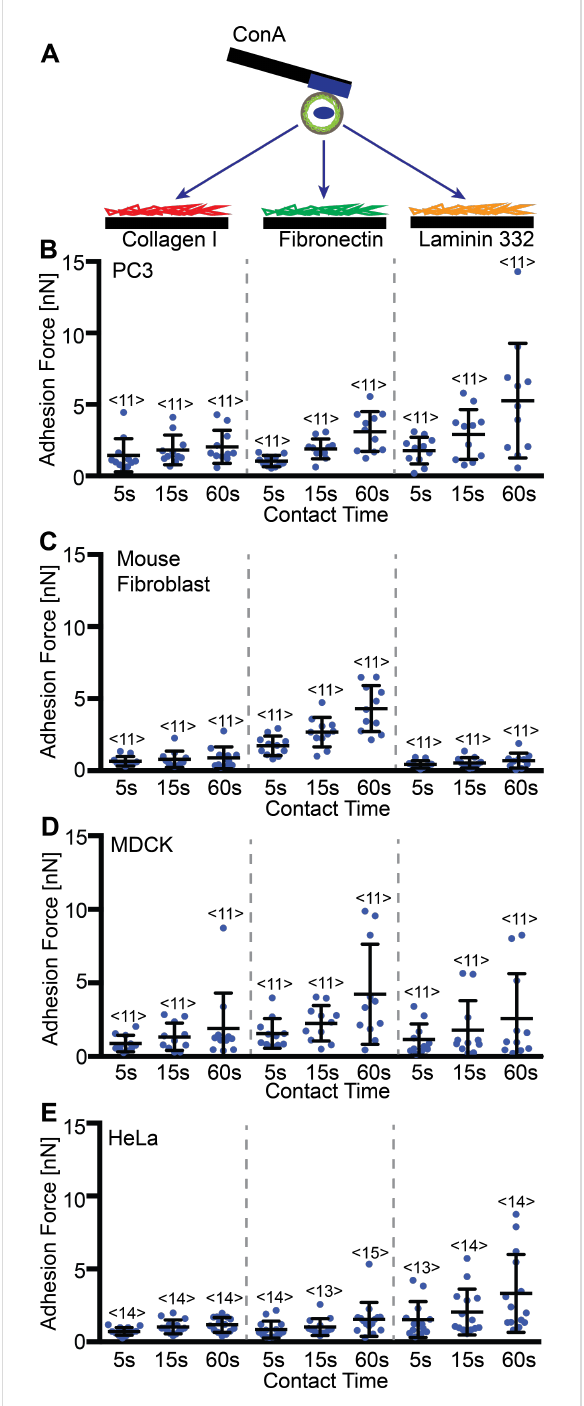
Figure 5: Cell line-dependent adhesion of ECM proteins. (A) Depic- tion of the SCFS experimental setup, where the adhesion of a ConA bound cell is measured to different protein-coated surfaces. Graphs of the adhesion forces measured for PC3 (B), mouse fibroblasts (C), MDCK (D) or HeLa (E) cells to collagen I, fibronectin and laminin 332 coated PDMS surfaces after contact times of 5, 15 and 60 s. Each dot represents the measurement of one cell. The number of cells assayed for each condition is given by < n >. Error bars indicate mean force and standard